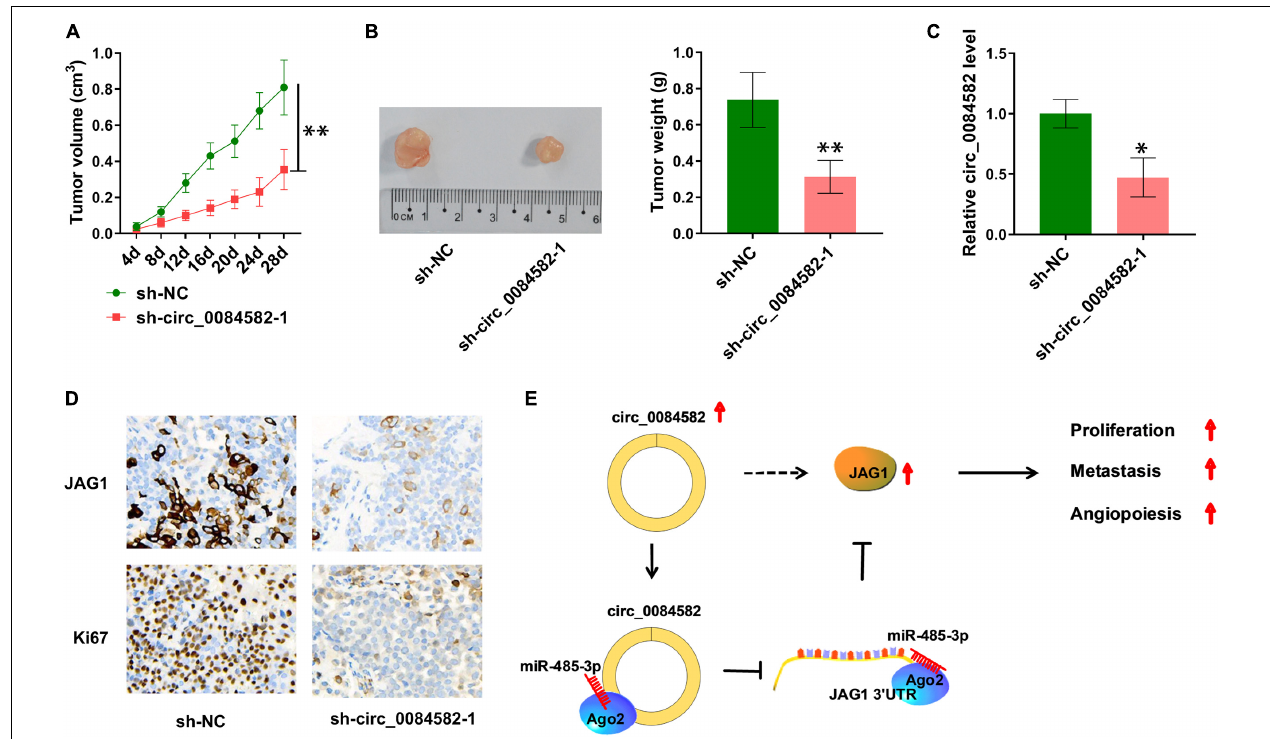
FIGURE 7 | Circ_0084582 regulates tumor growth of OS in vivo partly by the miR-485-3p/JAG1 axis. (A) Tumor volume of the sh-circ_0084582-1 or sh-NC groups was measured per 4 days. (B) Tumor tissues were photographed and weighed. (C) The circ_0084582 expression was detected by qRT-PCR in tumor tissues. (D) JAG1 and Ki67 protein levels in excised tissues were assayed via IHC analysis. (E) The graphical summary of this study. All experiments were performed with three biological replications. ∗ P < 0.05, ∗∗ P <